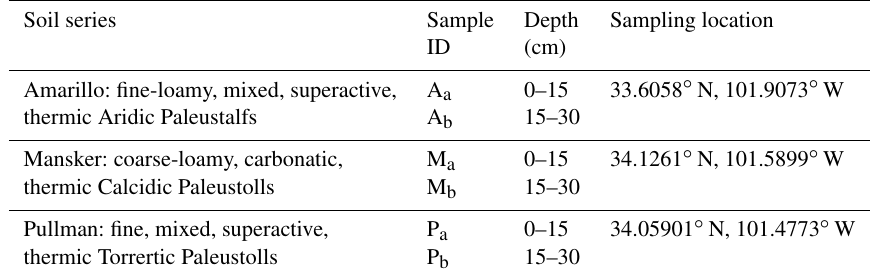
Table 1. Soil classification and identification of the studied semi-arid alkaline soils of the Southern High Plains, USA. Soil series Sample Depth Sampling location ID Amarillo: fine-loamy, mixed,